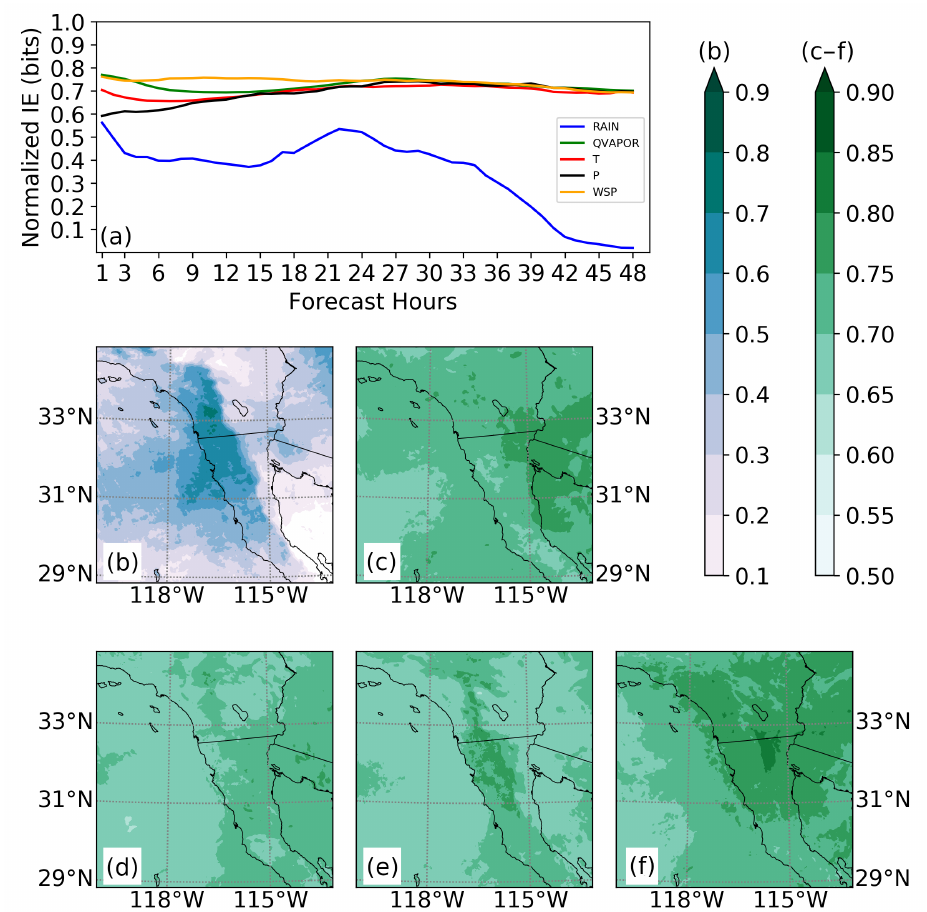
Figure 7. Temporal evolution ( a ) and spatial distribution ( b – f ) of information entropy computed for rain, temperature, water vapor, pressure, and wind speed from ( b – f ), respectively. Valid for the simulation period starting at 00Z on 27 February